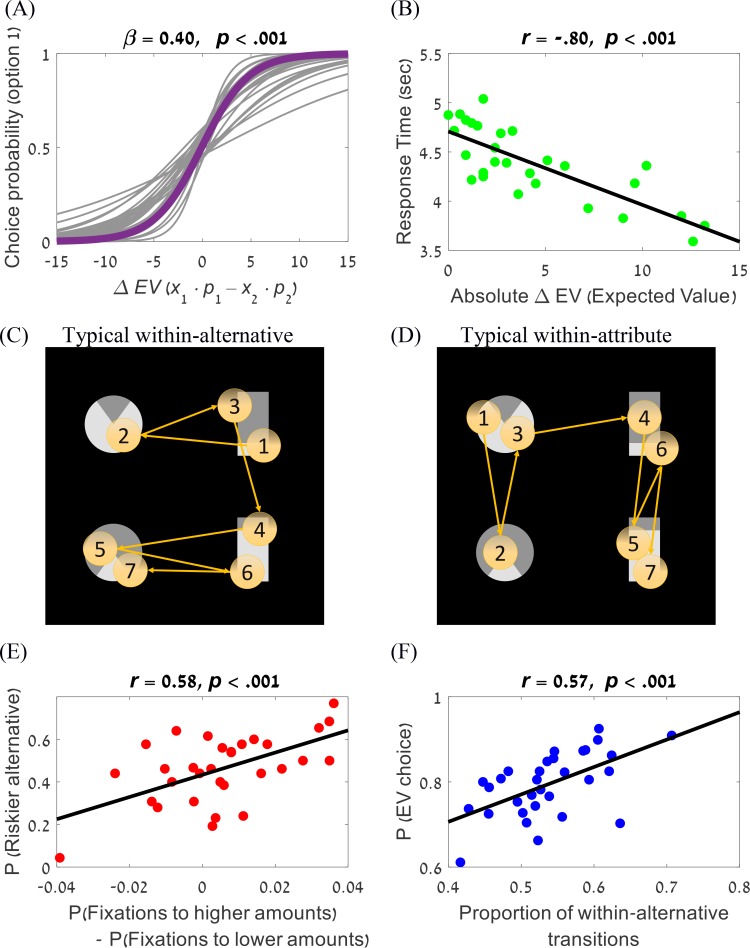
Choice and eye-movements analysis.(A) The participants were sensitive to EV differences between the options. Solid purple line corresponds to the group fit; grey lines correspond to the fit of individual participants. (B) Response times were negatively correlated with the alternatives' EV differences. (C-D) Example eye-trajectory characterized by within-alternative transitions (in C) and by within-attribute transitions (in D). The numbers indicate the order of fixations. (E) The difference in proportion of fixations to higher and lower amount was correlated with risk-seeking preference. (F) The proportion of within-alternative transitions correlated with the proportion of higher EV choices.